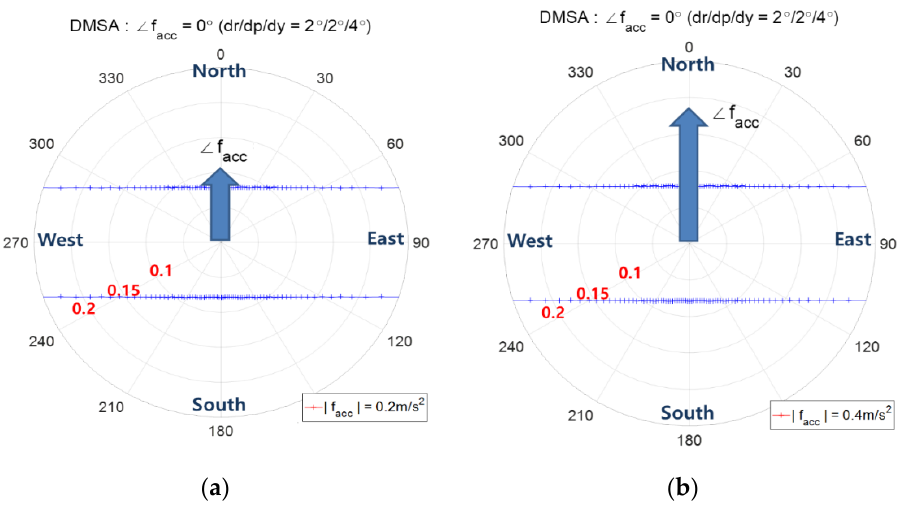
Figure 12. Contour of DMSA using the decision variable 𝒛 𝒂𝒃𝒔𝑵 ( ∠ 𝐟 𝐚𝐜𝐜 = 0° ), the angle denotes the direction of 𝒇 𝒔 , i.e., ∠ 𝒇 𝒔 ; ( a ) |𝒇 𝒂𝒄𝒄 | = 0.2𝑚/𝑠 2 ( b ) |𝒇 𝒂𝒄𝒄 | = 0.4𝑚/𝑠 2 .